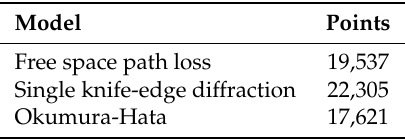
Table 3. Comparison in number of points found in coverage from a total of 96,431